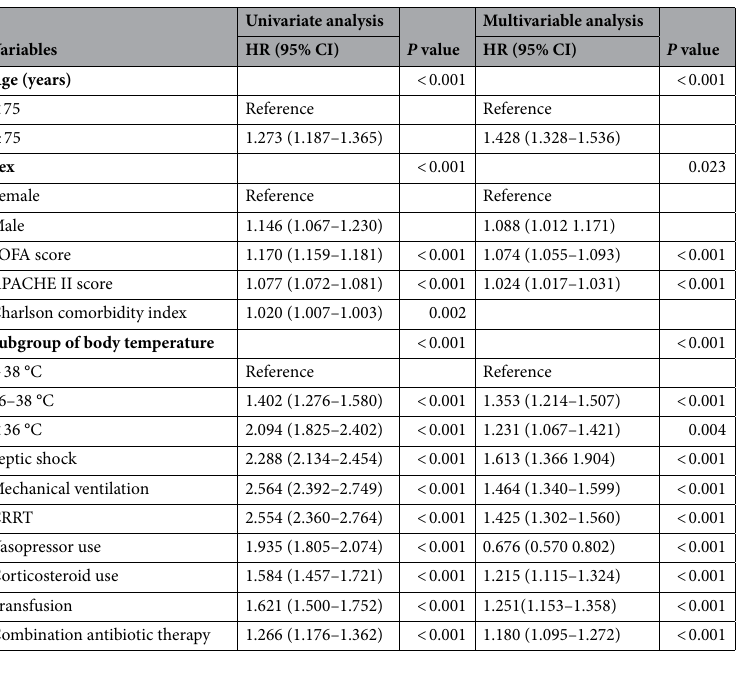
Table 2. Cox’s proportional analyses of variables associated with 90-day mortality. HR, hazard ratio; CI, confidence interval; SOFA, sequential organ failure assessment; APACHE, acute physiology and chronic health evaluation; and CRRT, continuous renal replacement